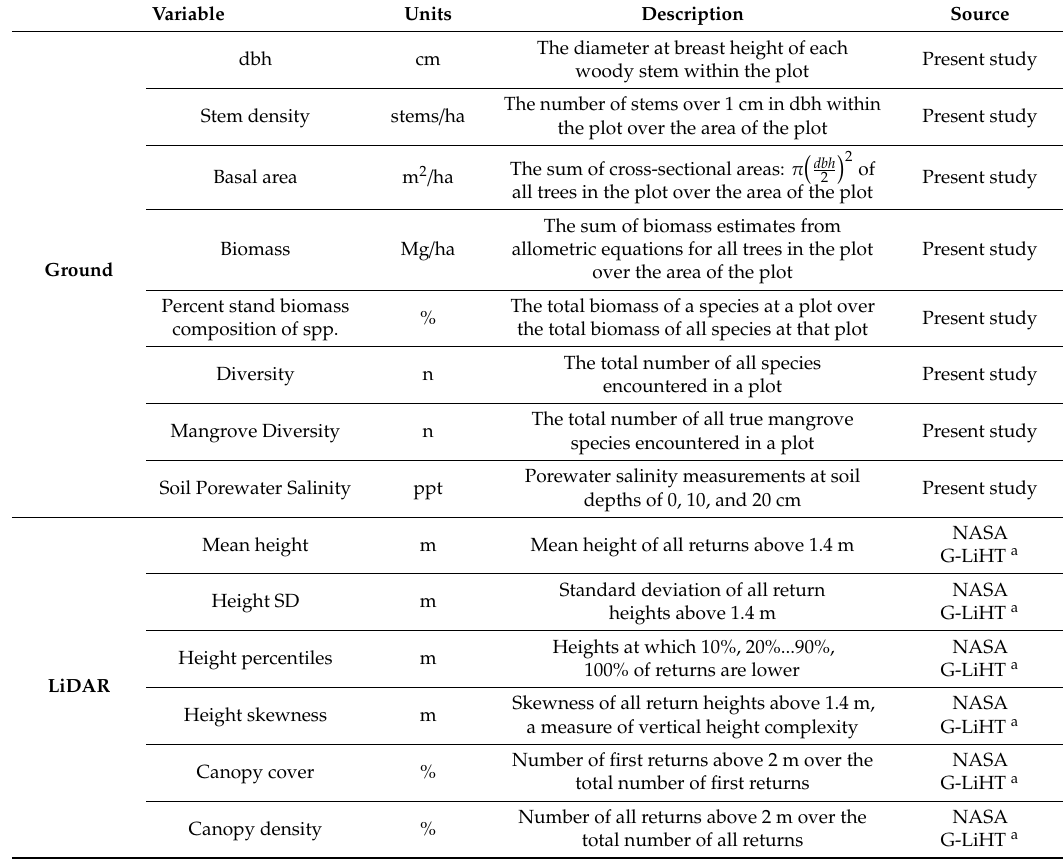
Table 2. Variables used to describe forest structure and